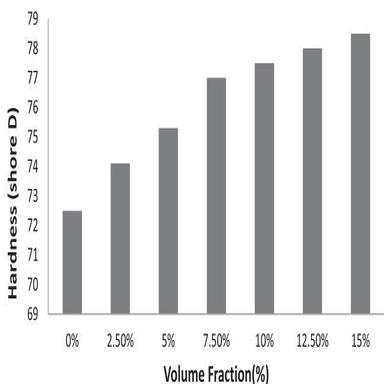
The effect of the volume fraction of wool on Hardness for epoxy volume percentage (0–15%).